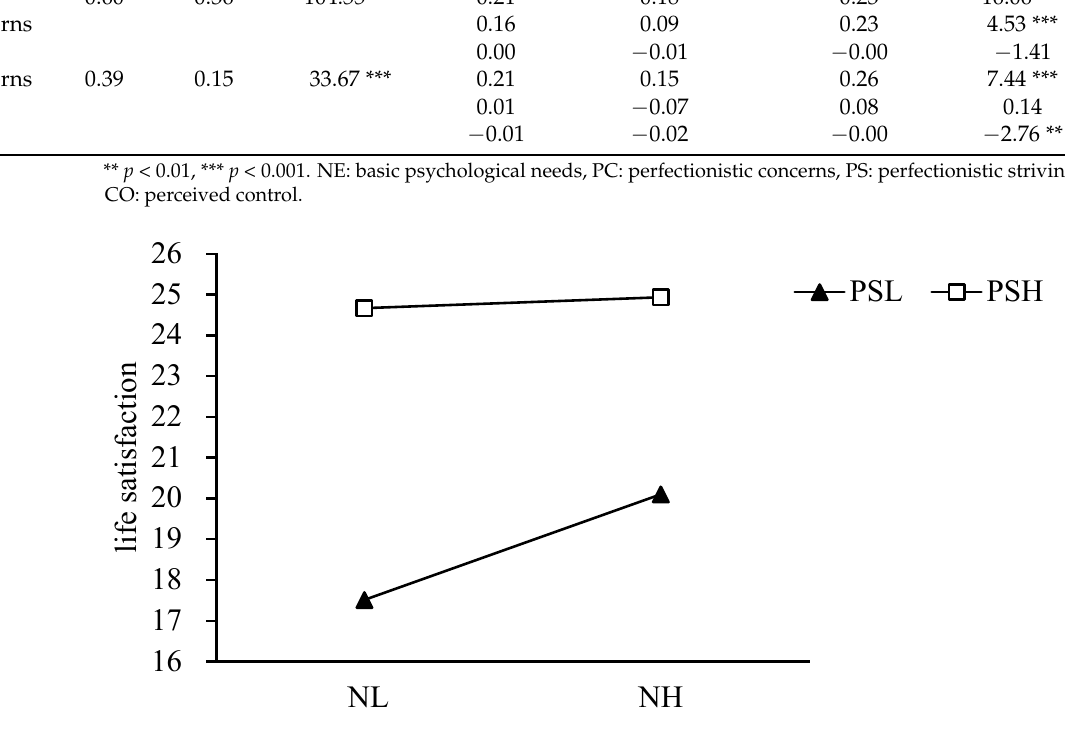
Figure 2. The moderating effect of perfectionistic strivings on the relationship between perceived control and life satisfaction. COL: low perceived control, NH: high low perceived control, PSL: low perfectionistic strivings, and PSH: high perfectionistic strivings. 3.3. The Moderating Effect of Perfectionistic Concerns The results showed that perfectionistic concerns did not moderate the relationship between basic psychological needs and life satisfaction, but moderated the relationship between perceived control and life satisfaction. Simple slope analysis further analyzed the moderating effect of perfectionistic concerns on the relationship between perceived con ‐ trol and life satisfaction. Additionally, the high perfectionistic concerns group (higher than the average plus one standard deviation) and the low perfectionistic concerns group (lower than the average plus one standard deviation) were selected for the simple slope test [51]. High perfectionistic concerns group: simple slope = 0.15, 95% confidence interval [0.06, 0.22], p < 0.001. Low perfectionistic concerns group: simple slope = 0.27, 95% confi ‐ dence interval [0.21, 0.33], p < 0.001. The simple slope is shown in Figure 3. This suggests that increased feelings of control increase life satisfaction, but perfectionistic concerns re ‐ duce the positive relationship between perceived control and life satisfaction. At the same